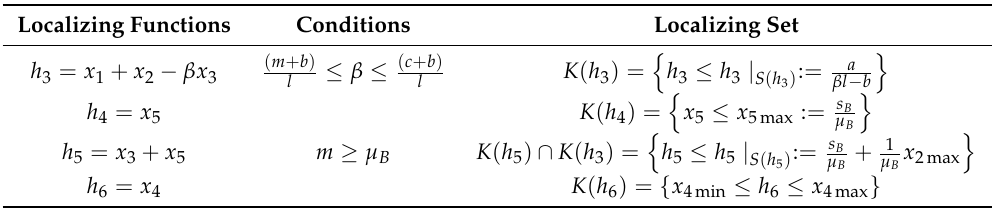
Table 2. Upper and lower